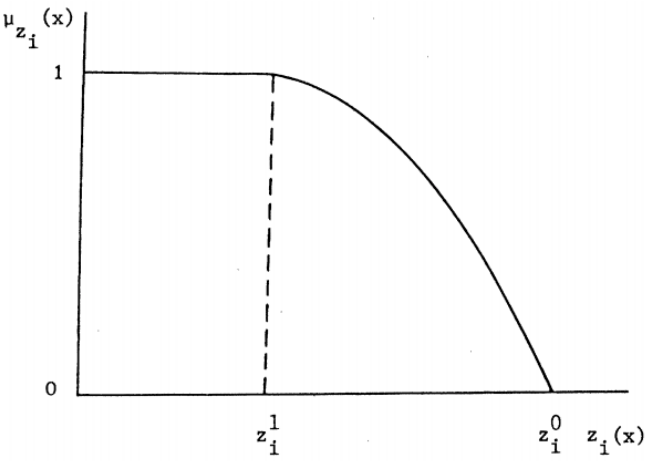
Figure 3. Membership function example presented in [22].